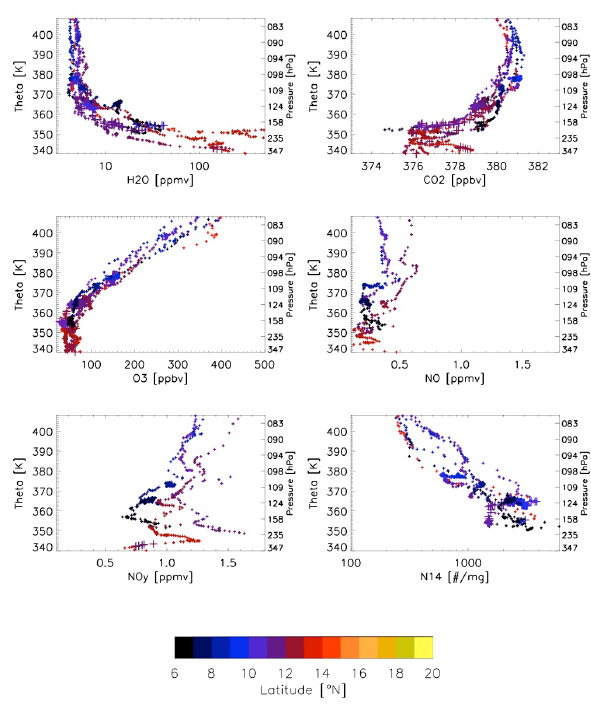
Fig. 10b. Vertical profiles of trace gas concentrations (volume mixing ratio in ppbv or ppmv as appropriate) and aerosol mass mixing ratio (particles per mg air), N 14 (14nm to < 1µm), for “non-convective” M55 flights on 4 and 13 August 2006. Profiles are plotted as a function of theta (K) and coloured by latitude where the measurements were made. Crosses indicate points where back trajectories show uplift from below 800hPa during 10 days before the flight.